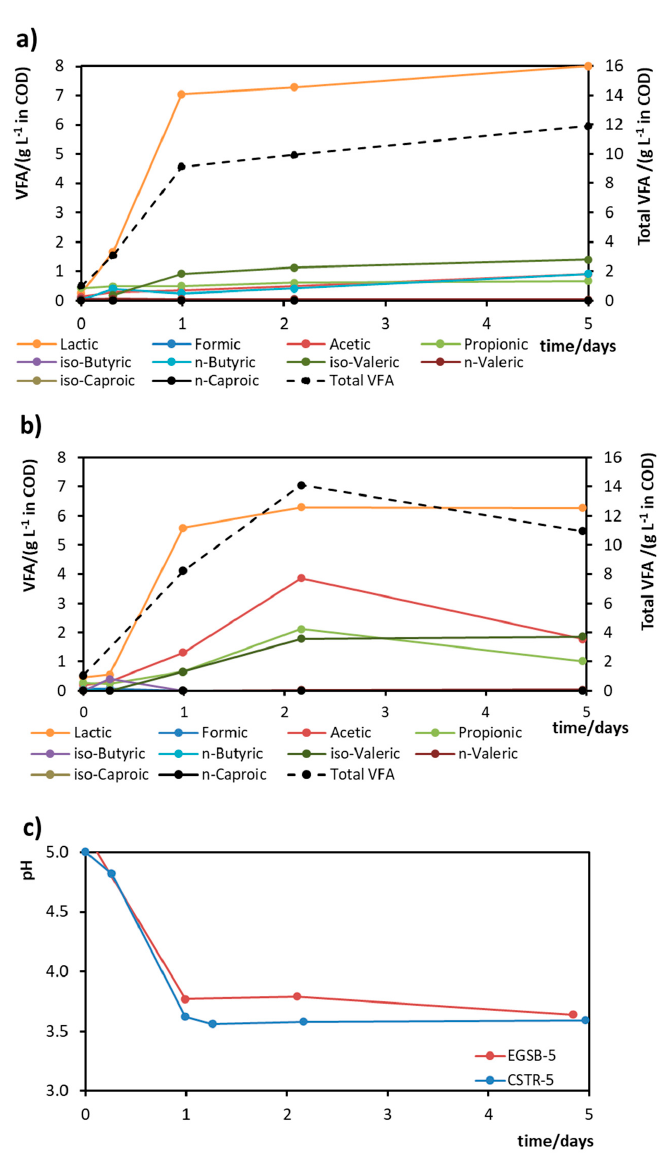
Figure 2. VFA and lactic acid profiles in reactors GSBC-5 ( a ) and BSR-5 ( b ), over time. ( c ) Time course of pH in reactors GSBC-5 and BSR-5.